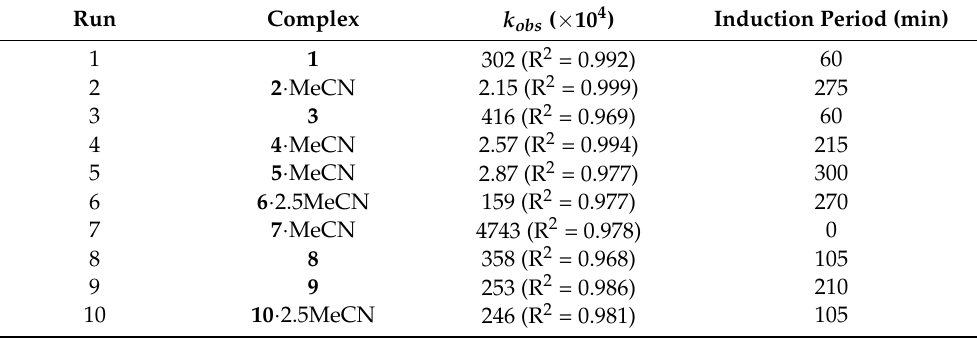
Figure 11. Plot of ln(CL 0 /CL t ) versus time. Left: complexes 1 , 3 and 6 – 10 ; Right: complexes 2 , 4 and 5 (Table 1, entries 1 – 10). Table 2. Kinetics constants for the ROP of ε -CL catalyzed by 1 – 10 at 100 °C.